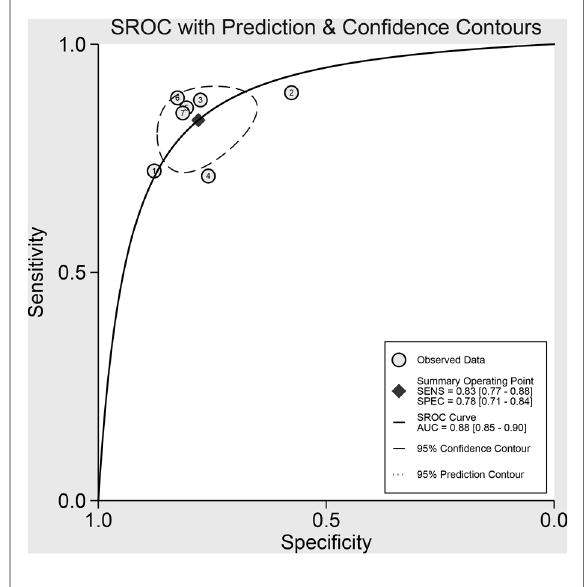
FIGURE 5 Summary receiver operating characteristic curves (sROC) based on radiomics for preoperative prediction of LMN in BTCs.